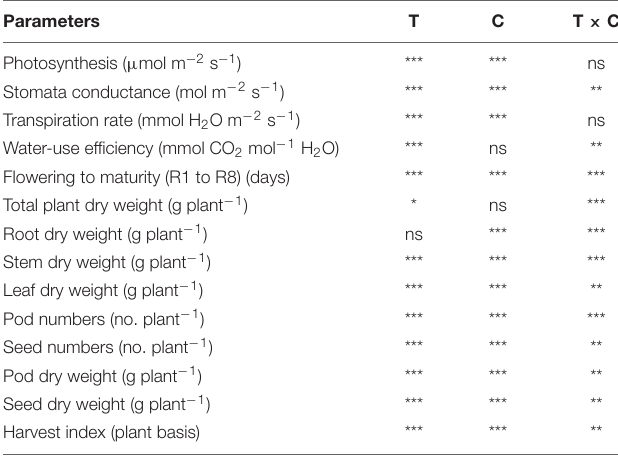
TABLE 2 | Analysis of variation across the temperatures (T), cultivars (C), and their interaction (T × C) with morphological and physiological traits.